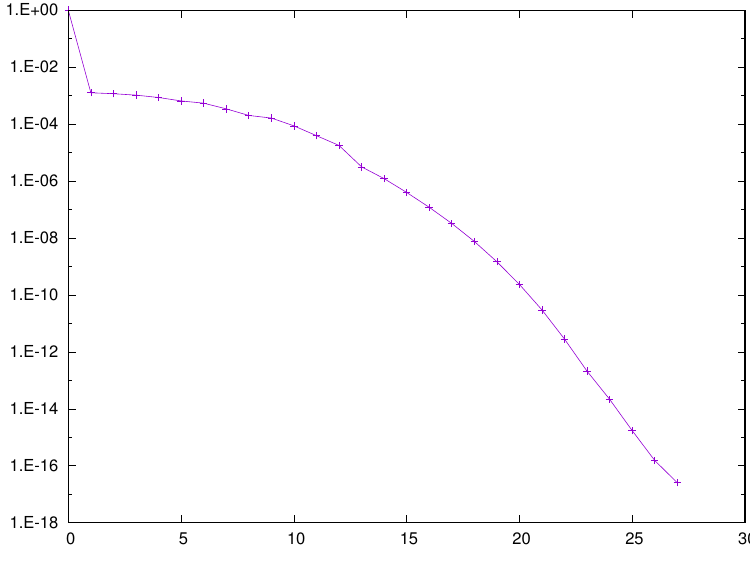
Figure 6. Significant